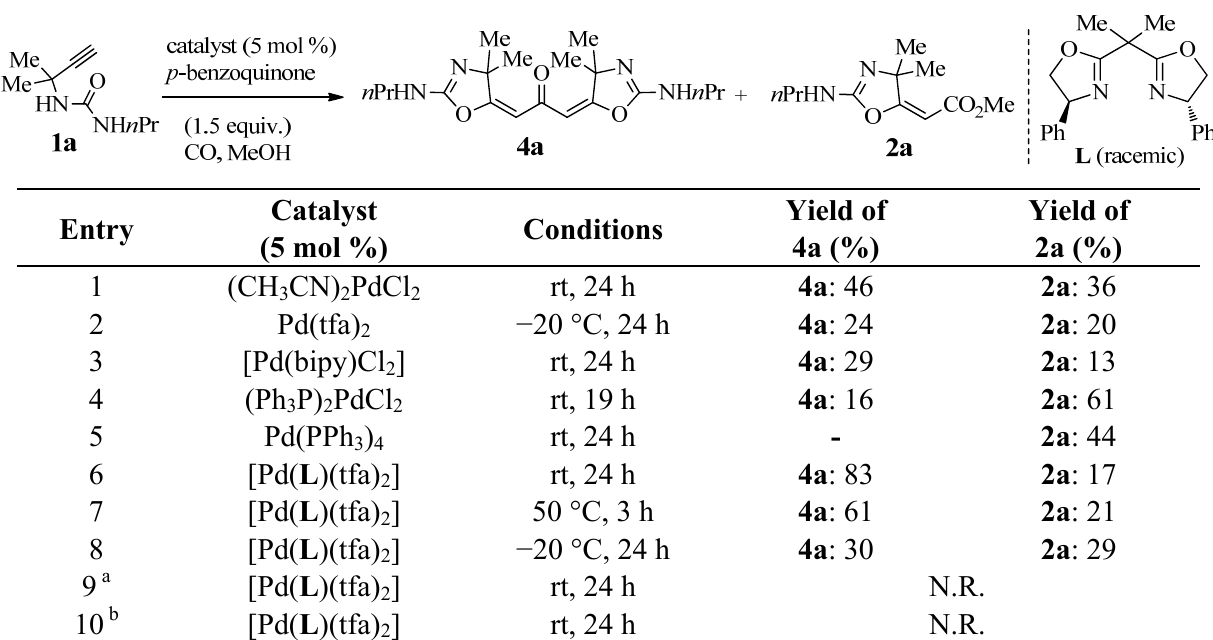
Table 1. Optimization of reaction